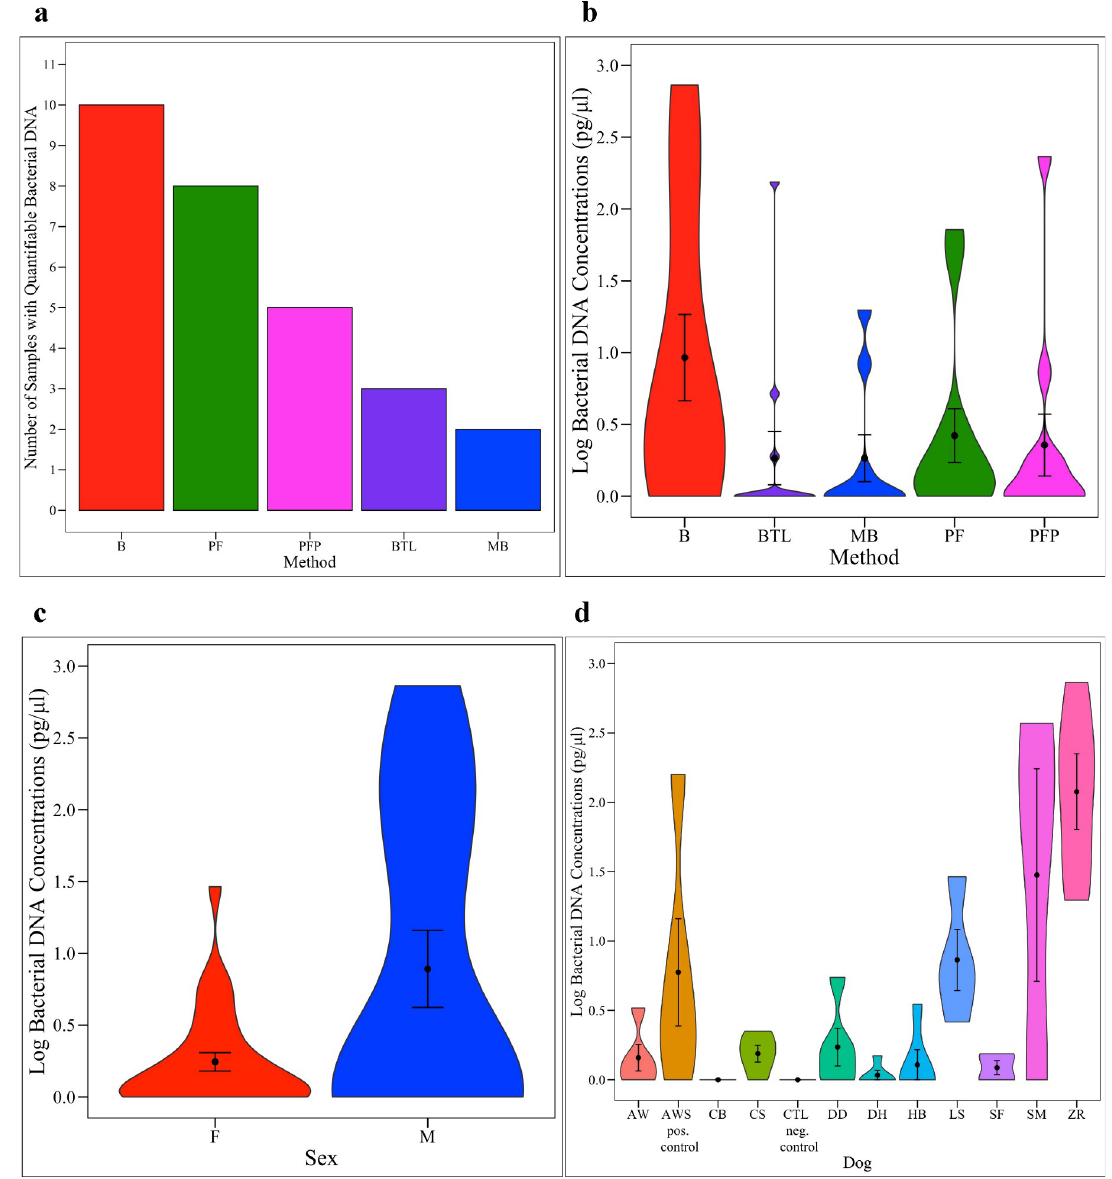
Fig 2. Bacterial DNA concentrations. ( a ) Number of samples with measurable bacterial DNA by extraction method. Bacterial DNA concentrations, calculated via qPCR, by ( b ) extraction method, ( c ) sex and ( d ) dog. Bacterial DNA concentrations differed significantly by extraction method (Kruskal-Wallis, p = 0.044) and by dog (Kruskal-Wallis, p = 0.0005); although, no pairwise comparisons were significant. Bacterial DNA concentrations did not differ significantly by sex (Kruskal-Wallis, p = 0.333; positive control excluded). B = Bacteremia, BTL = Blood & Tissue with Lysozyme, MB = Magnetic Beads, PF = PowerFecal 1 , PFP = PowerFecal 1 Pro, F = Female, M = Male. SM (3.4% variation) extracted using the B kit. All three samples were included in analyses. Quantifiable bacterial DNA concentrations ranged from 0.28 pg/ μ l to 729.48 pg/ μ l. The num- ber of samples with quantifiable bacterial DNA varied by extraction method ( Fig 2A ). Addi- tionally, bacterial DNA concentrations differed significantly by method ( Fig 2B , Kruskal- Wallis, p = 0.044) and by dog ( Fig 2D , Kruskal-Wallis, p = 0.0005); although, no pairwise